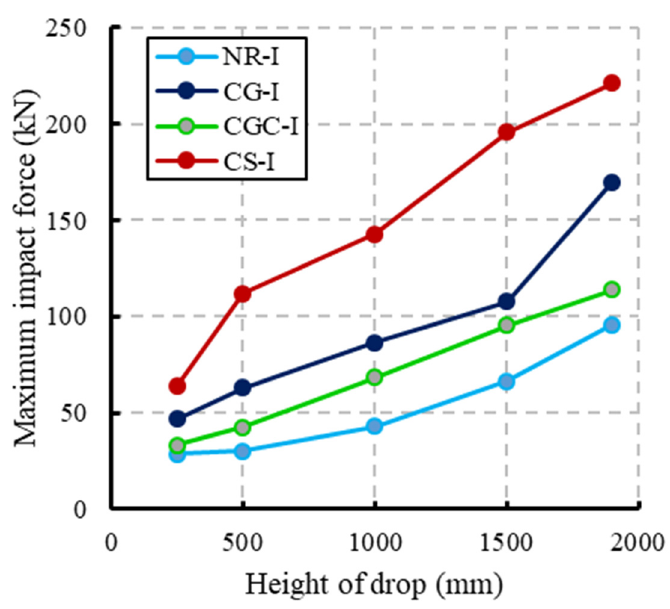
Figure 9. Comparisons of the maximum impact force for different heights of drop.